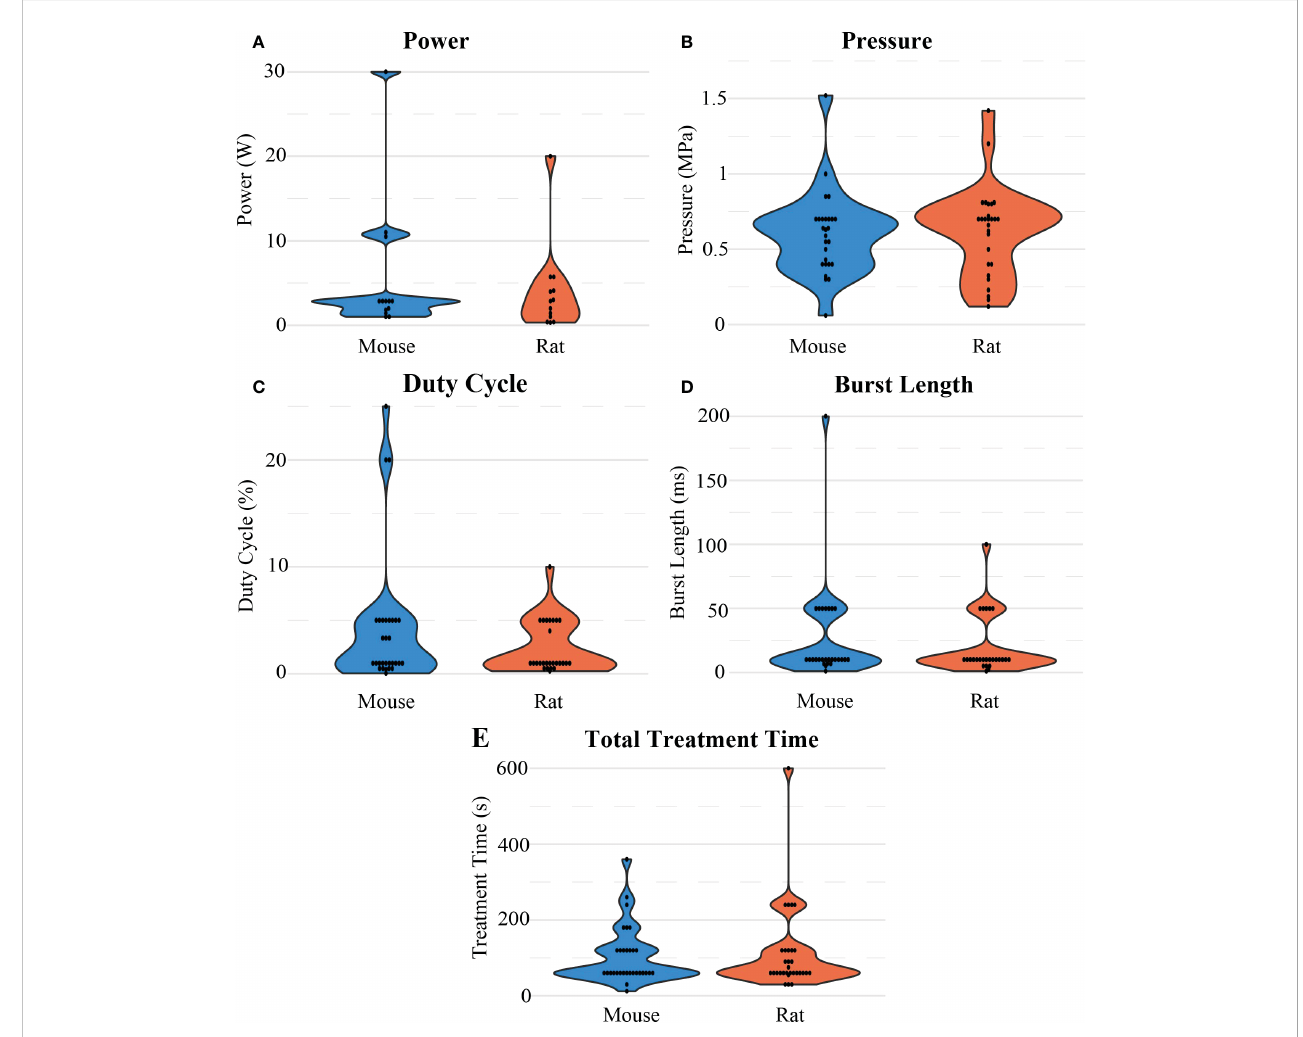
FIGURE 8 Distribution of different sonication parameters: (A) Power, (B) pressure, (C) duty cycle (D) burst length, and (E) total treatment time considered in the reviewed studies for FUS-mediated BBB opening experiments in mouse and rat